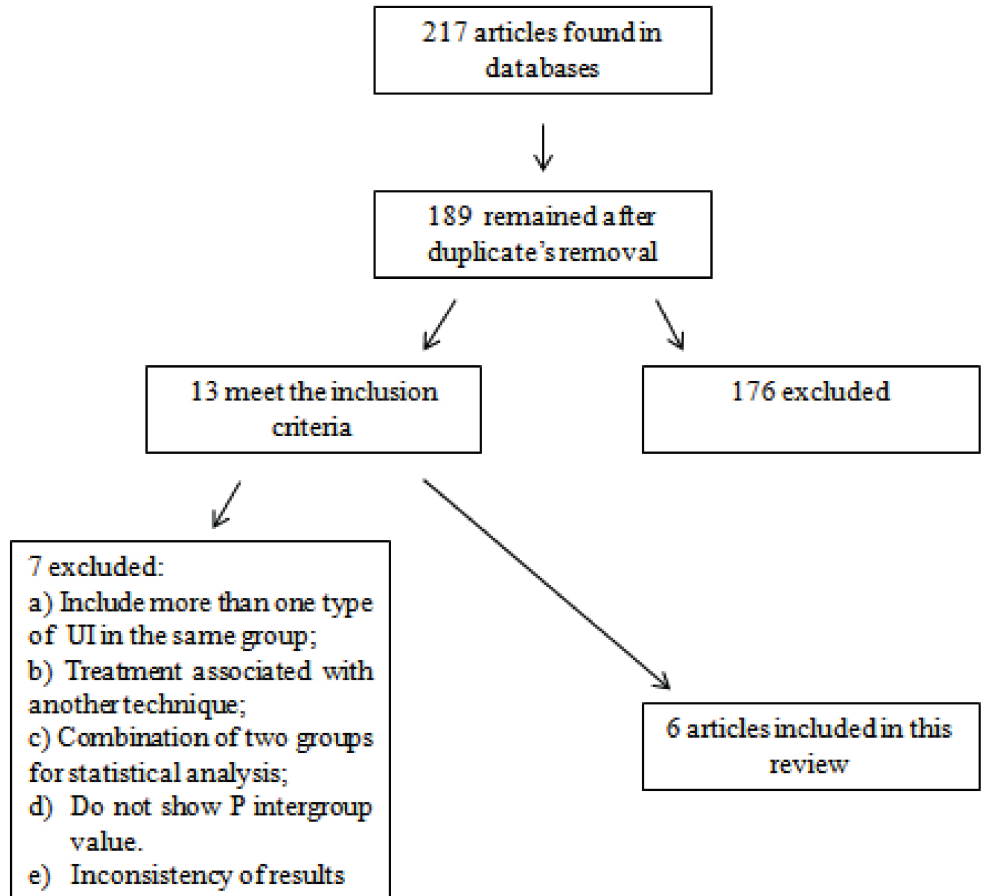
Figure 1 - Flowchart